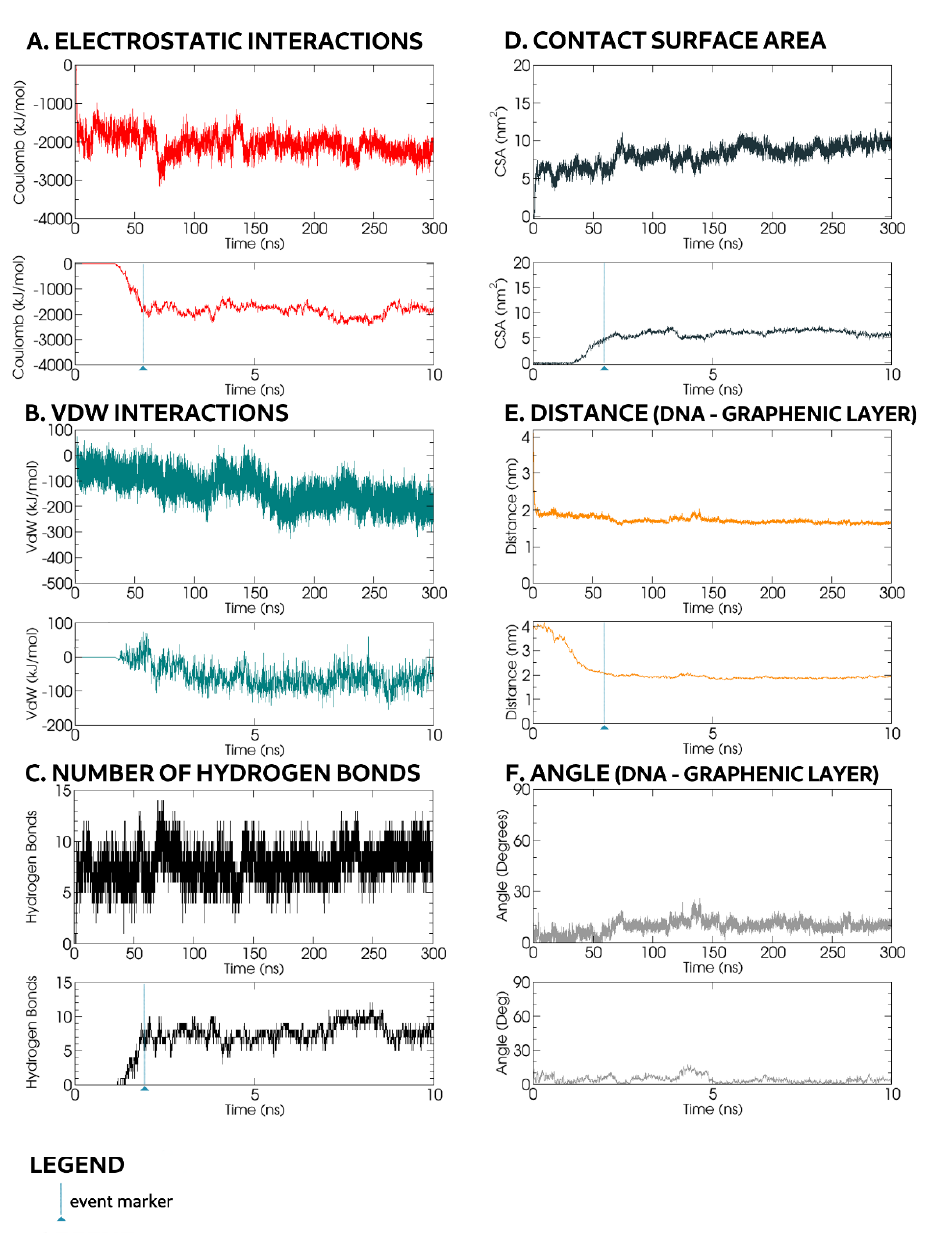
Figure 12. Evolution of different parameters over the 300 ns simulation time: ( A ) Electrostatic interactions between rGO and dsDNA; ( B ) VdW interactions between rGO and dsDNA; ( C ) Hydrogen bonds formed between rGO and dsDNA; ( D ) Contact surface area between rGO and dsDNA; ( E ) Distance between the dsDNA molecule and the graphenic layer; ( F ) Angle between the dsDNA molecule and the graphenic layer.